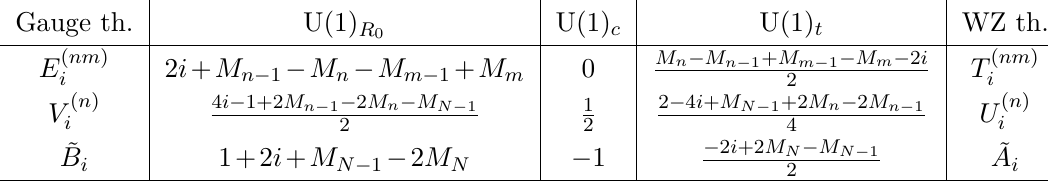
Table 4 . Charges under the abelian symmetries of the gauge invariant operators of the quiver theory and of the corresponding singlets of the WZ